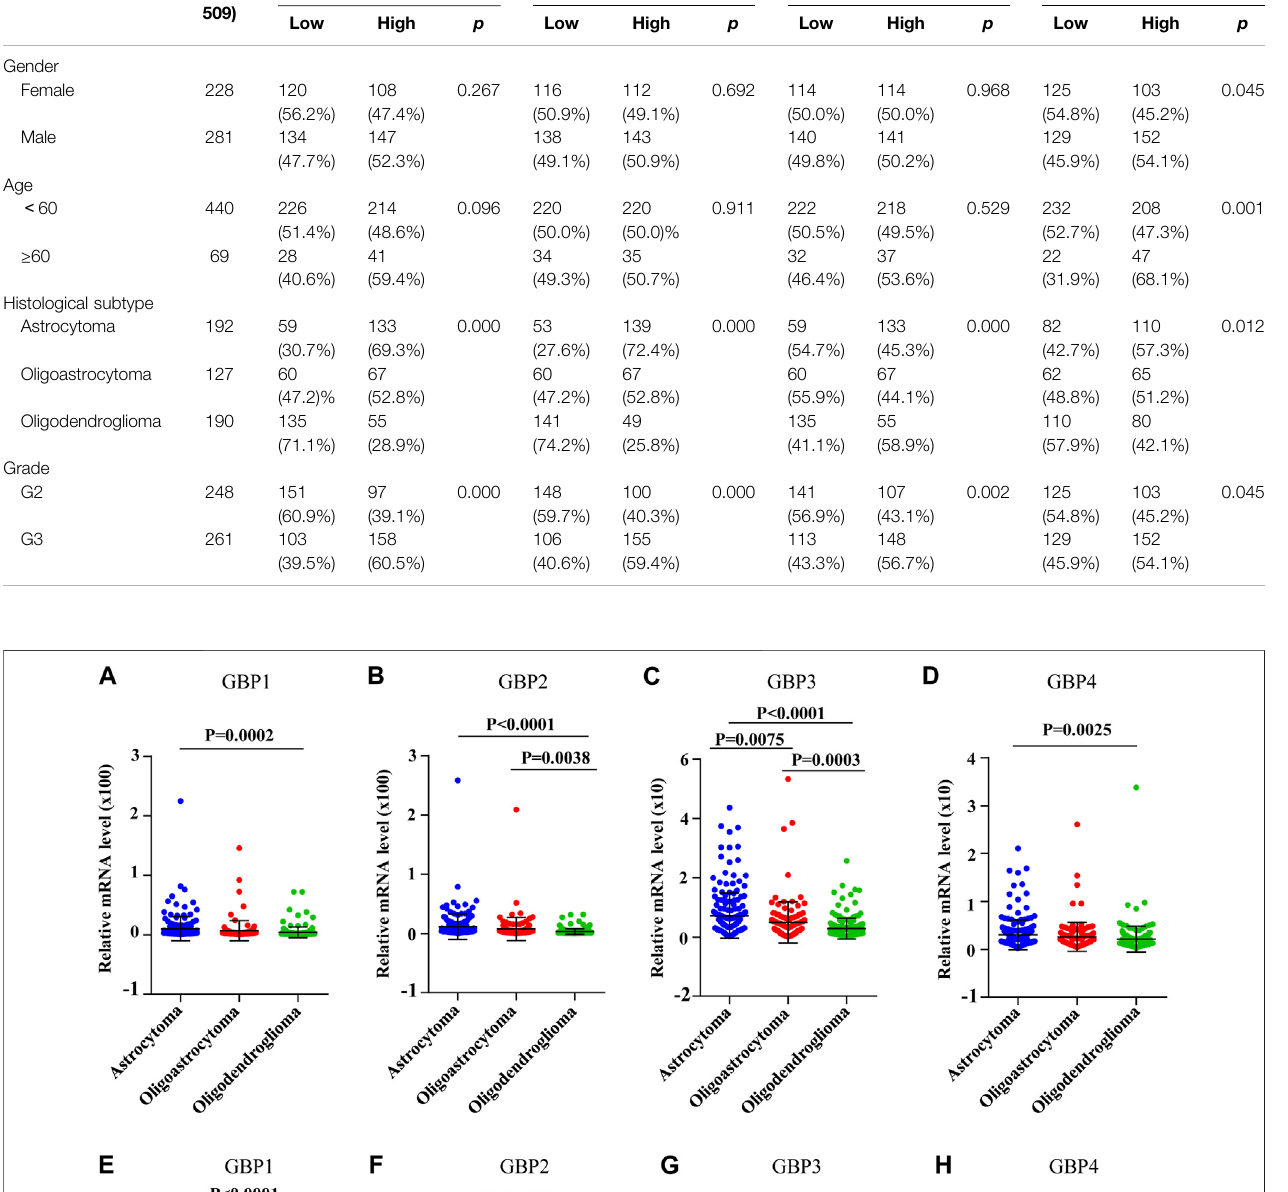
TABLE 2 | The correlation between GBP1/2/3/4 and clinicopathological parameters in LGG.